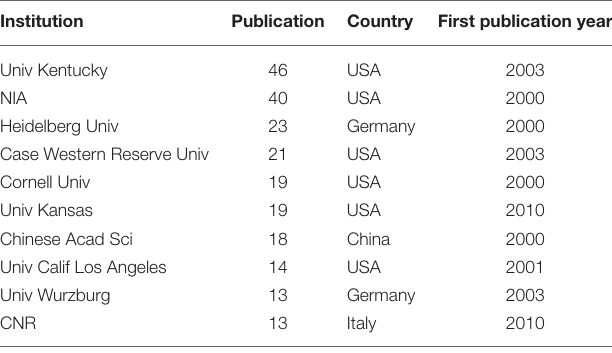
circles map, different colors correspond to different years. In the density visualizations map, the redder the color, the higher the density.